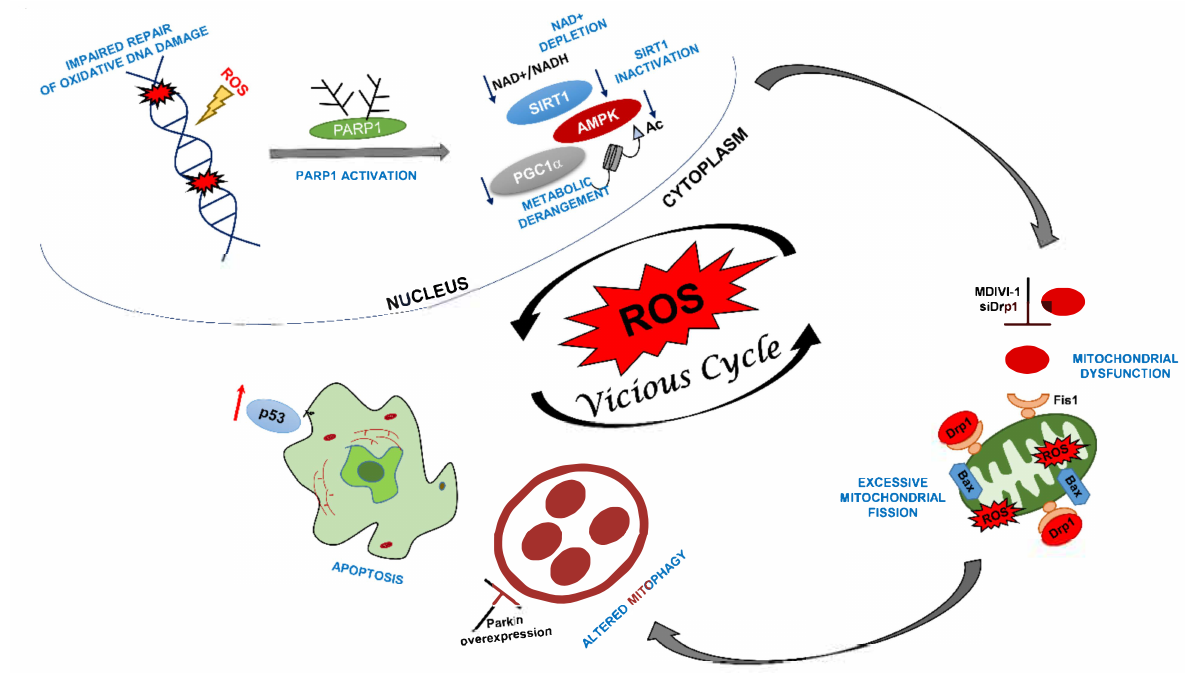
Figure 7. Schematic illustration of proposed mechanisms of neurodegeneration in CS-A